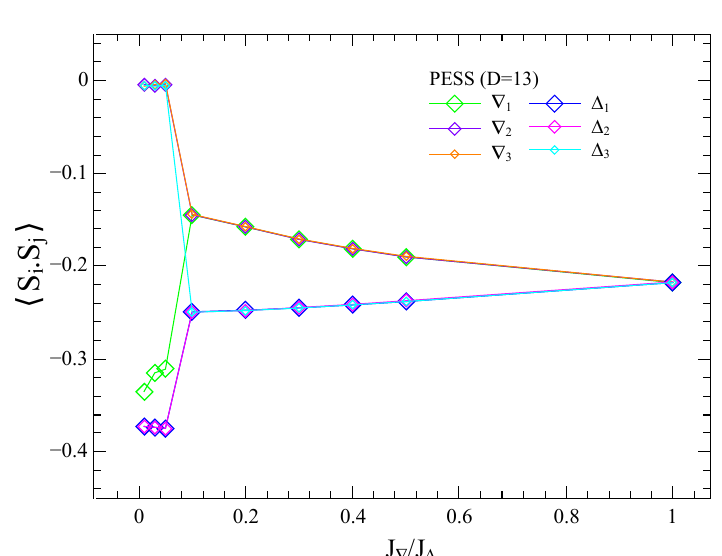
Figure 11: (Color online) Nearest-neighbor spin-spin correlations (obtained with PESS ( D = 13)) on the three links of an upward triangle, (cid:52) links of a downward triangle (cid:53) vation of C rotational symmetry at the level of each individual triangle in the U(1) 3 QSL phase and breaking of the C (cid:52) , (cid:52) are the average value of the correlation on the two 1 2